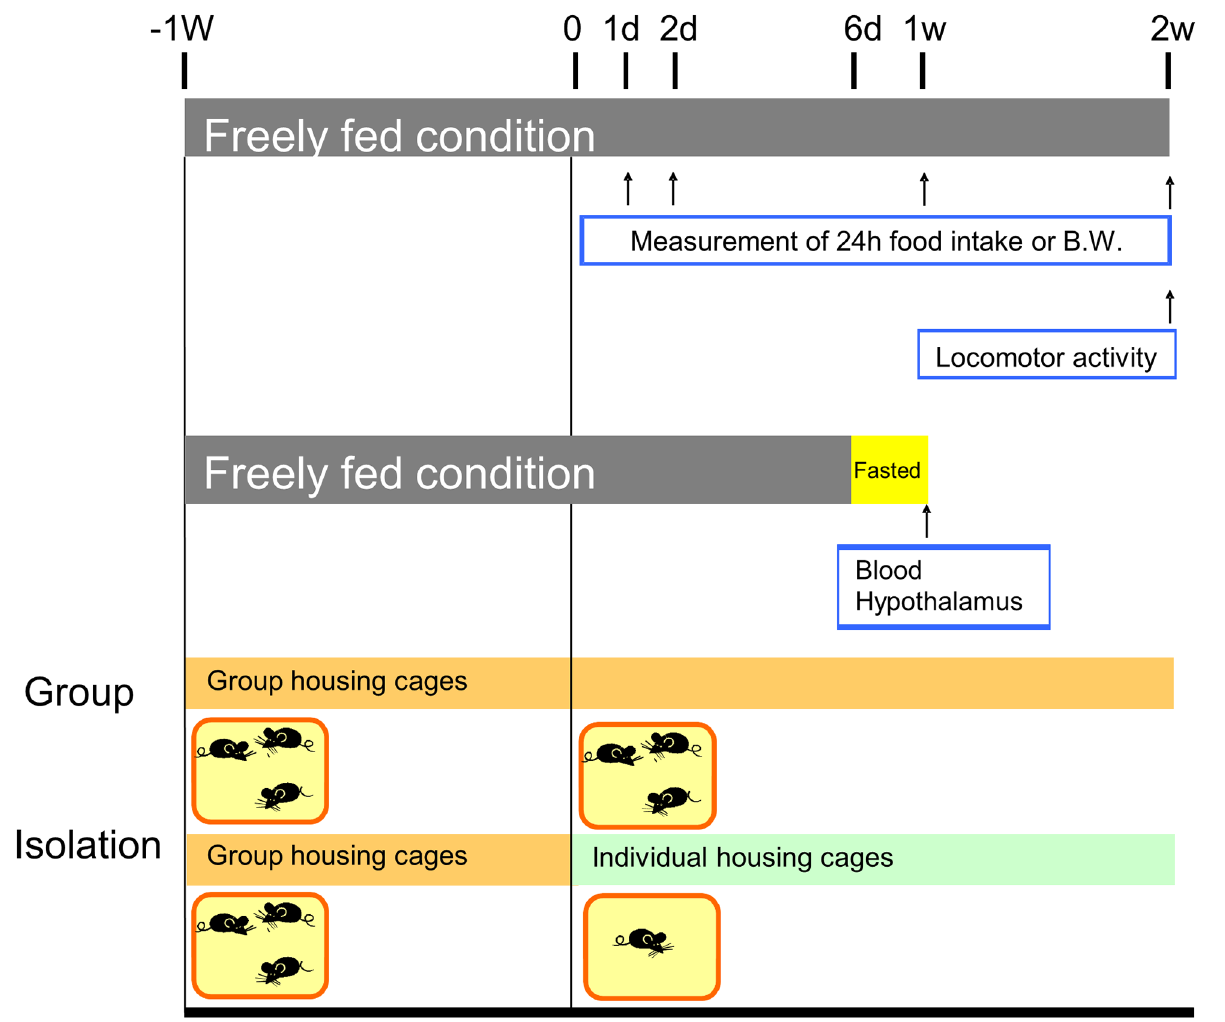
Fig 1. Experimental protocol employed in this